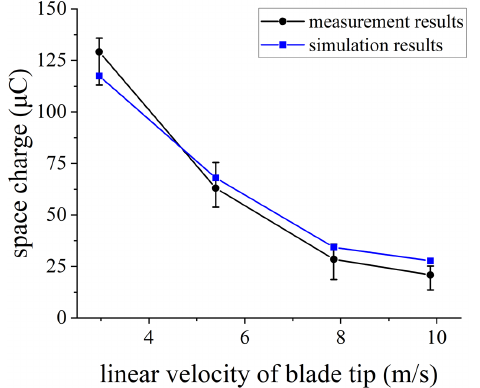
Figure 5. Results comparison of experiment and simulation on corona charge.